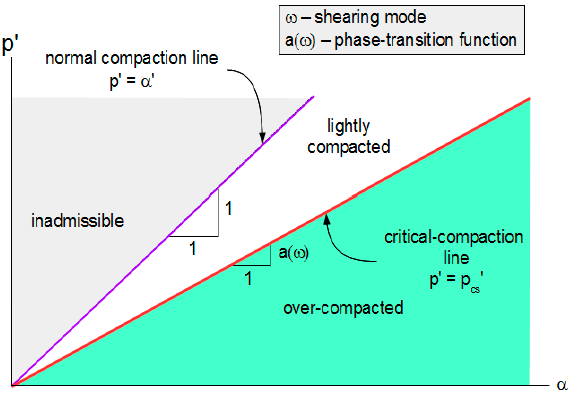
Figure 3. Partitioning of p’- α ’- ω space into lightly compacted and over-compacted domains.